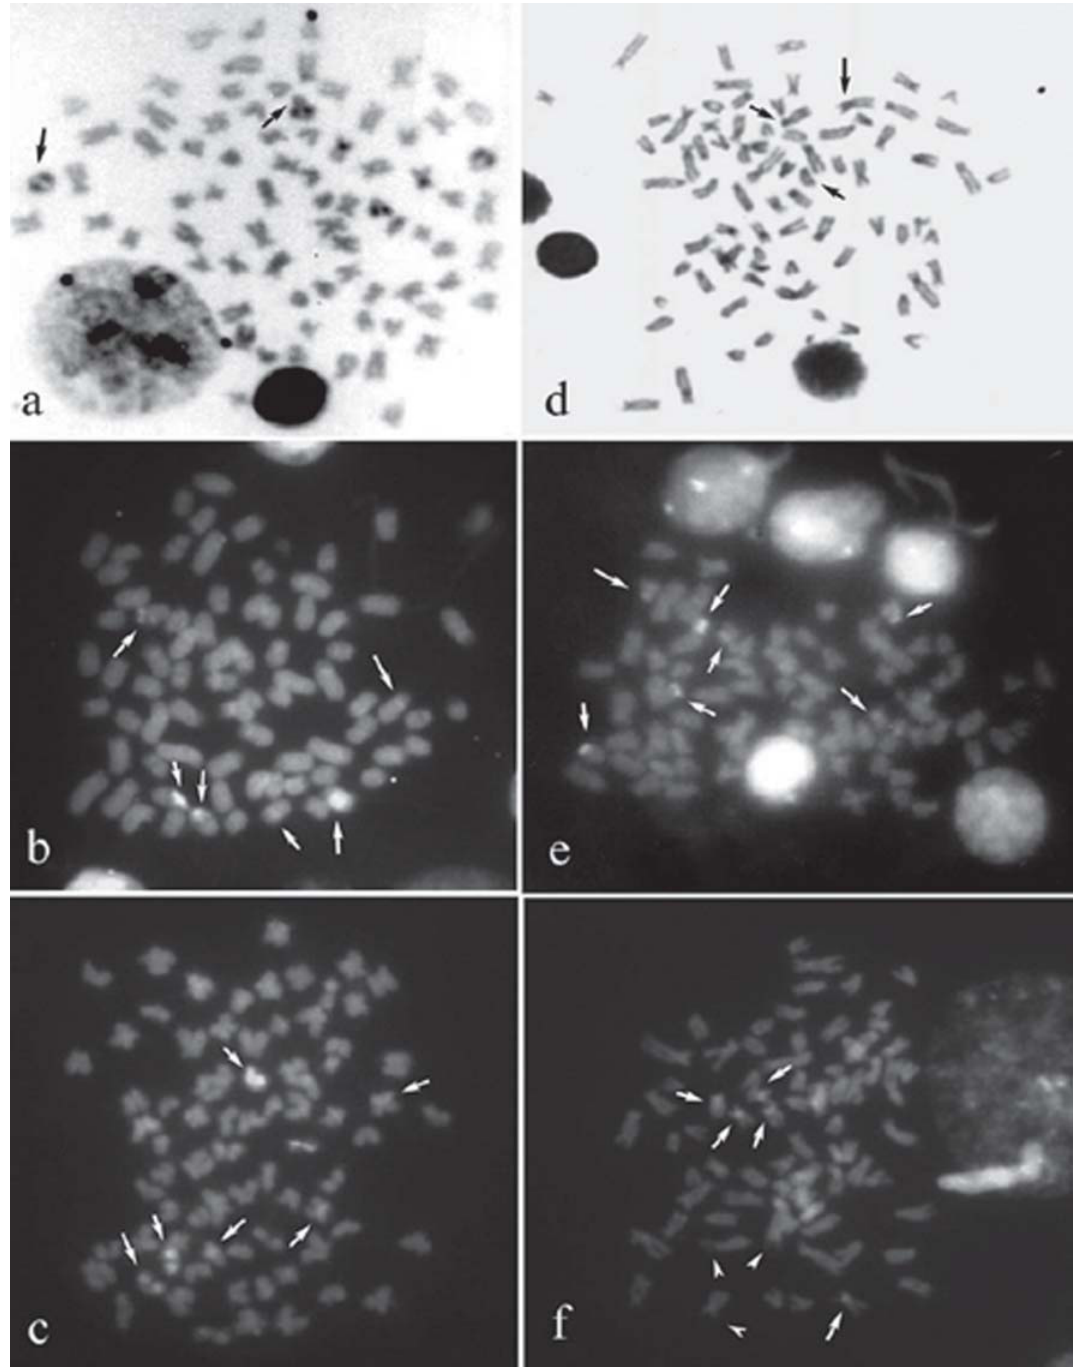
and DAPI, respectively. a) , b) and 3